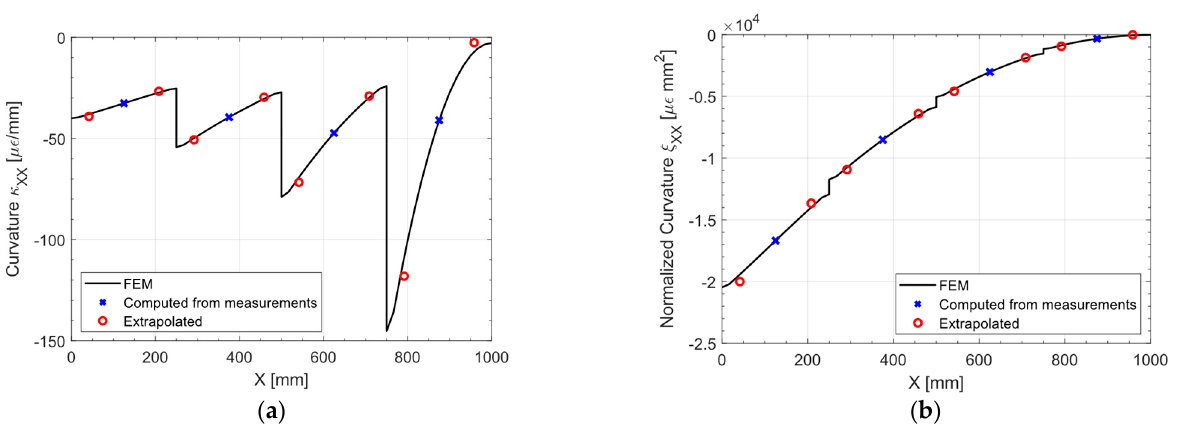
Figure 15 . Uniform pressure: ( a ) curvature 𝜅 (cid:3025)(cid:3025) and ( b ) normalized curvature 𝜉 (cid:3025)(cid:3025) , slice at Y = 250 Figure 15. Uniform pressure: ( a ) curvature κ XX and ( b ) normalized curvature ξ XX , slice at mm. Y = 250 mm.